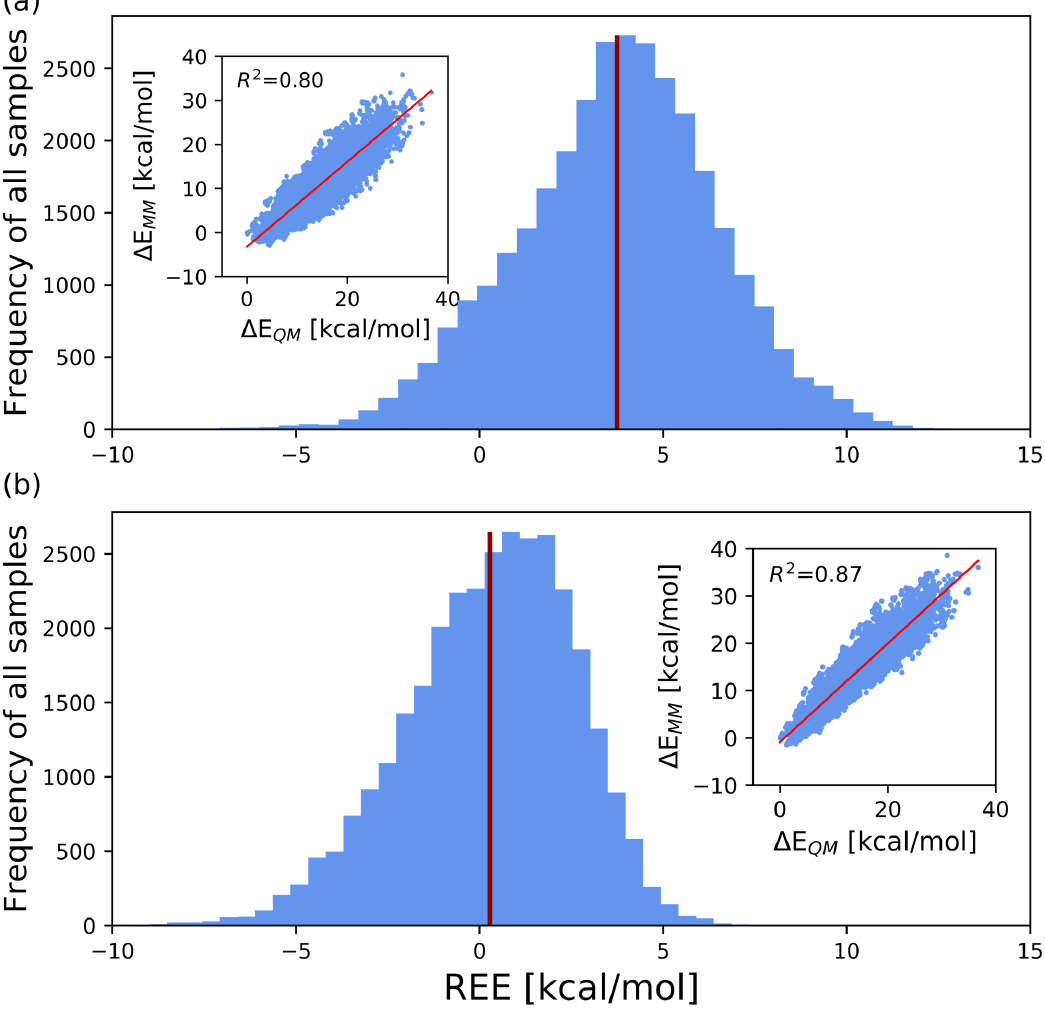
Figure 3. Histogram of REEs for all 31,899 structures, with REE on the abscissa and the number of samples on the ordinate. The red bars indicate the average values of REE. The scatter diagram in the inset is also plotted with ∆ E QM on the abscissa and ∆ E MM on the ordinate. ( a , b ), respectively, show the results obtained using the GLYCAM06 force field framework and our proposed force field framework for computing the MM